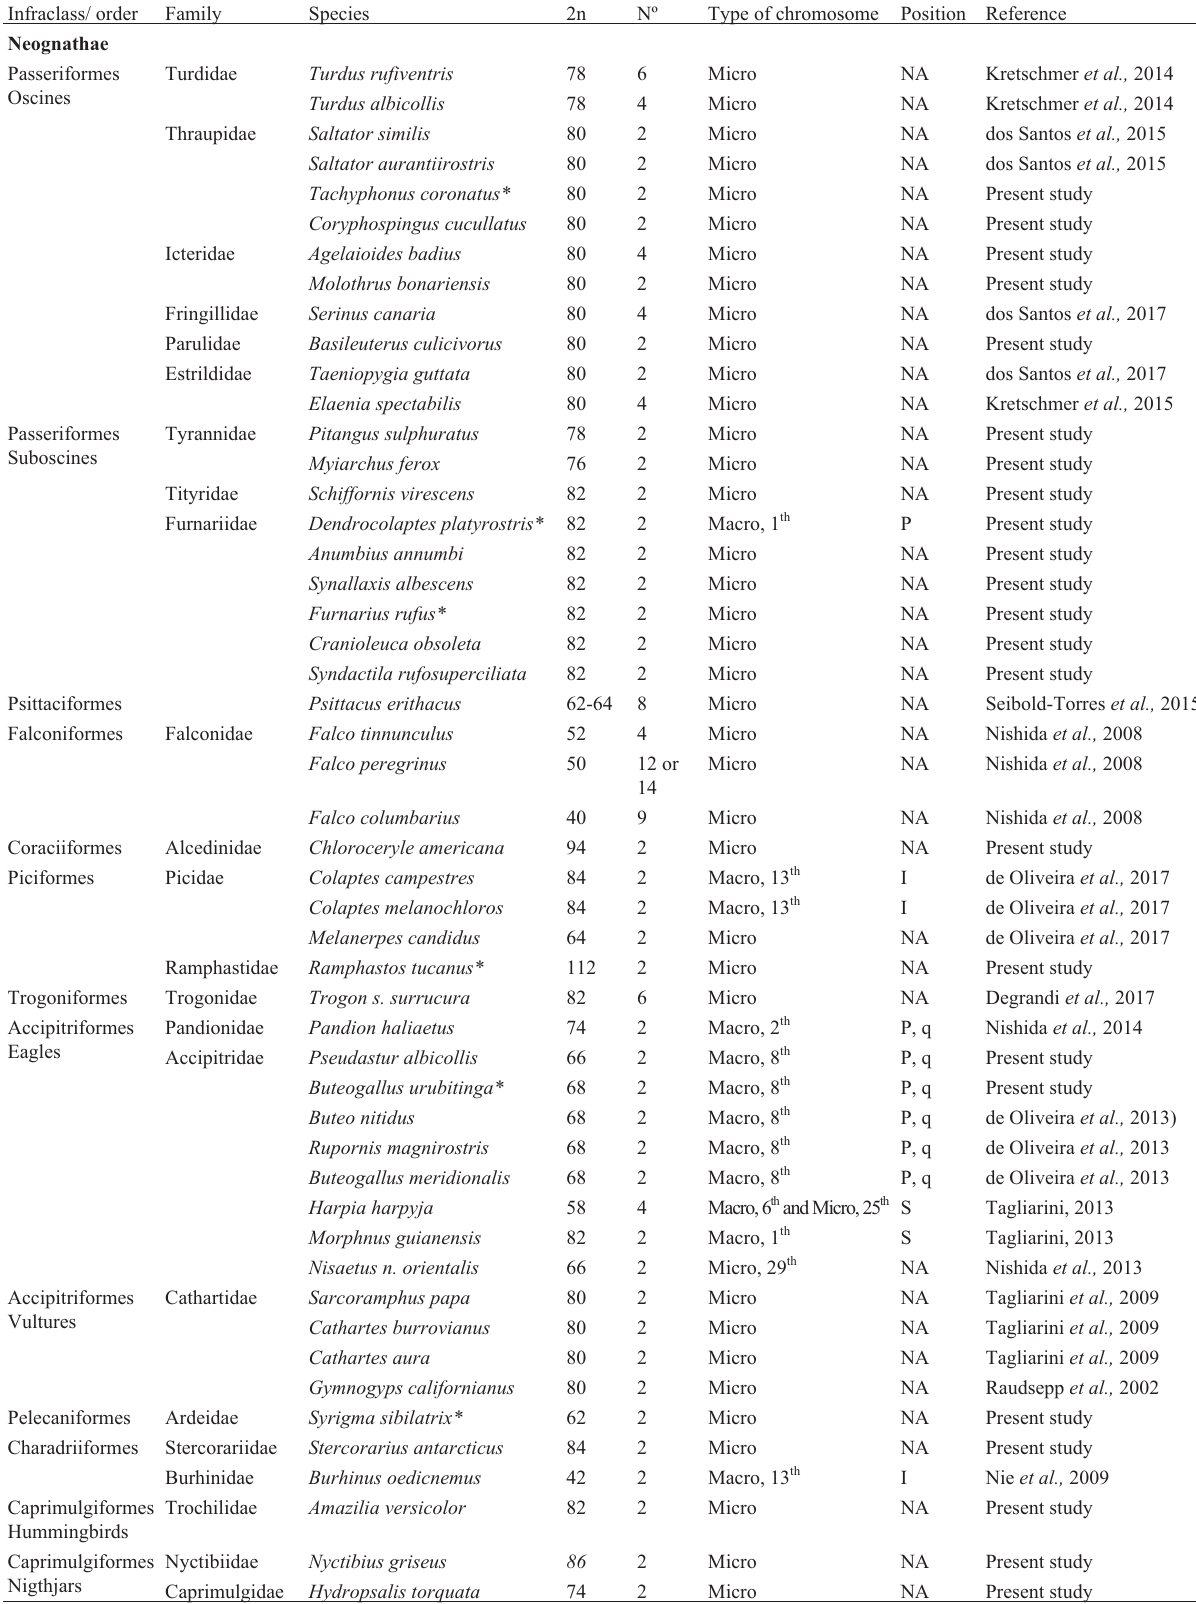
Table 1 - Distribution of 45S rDNA clusters in bird